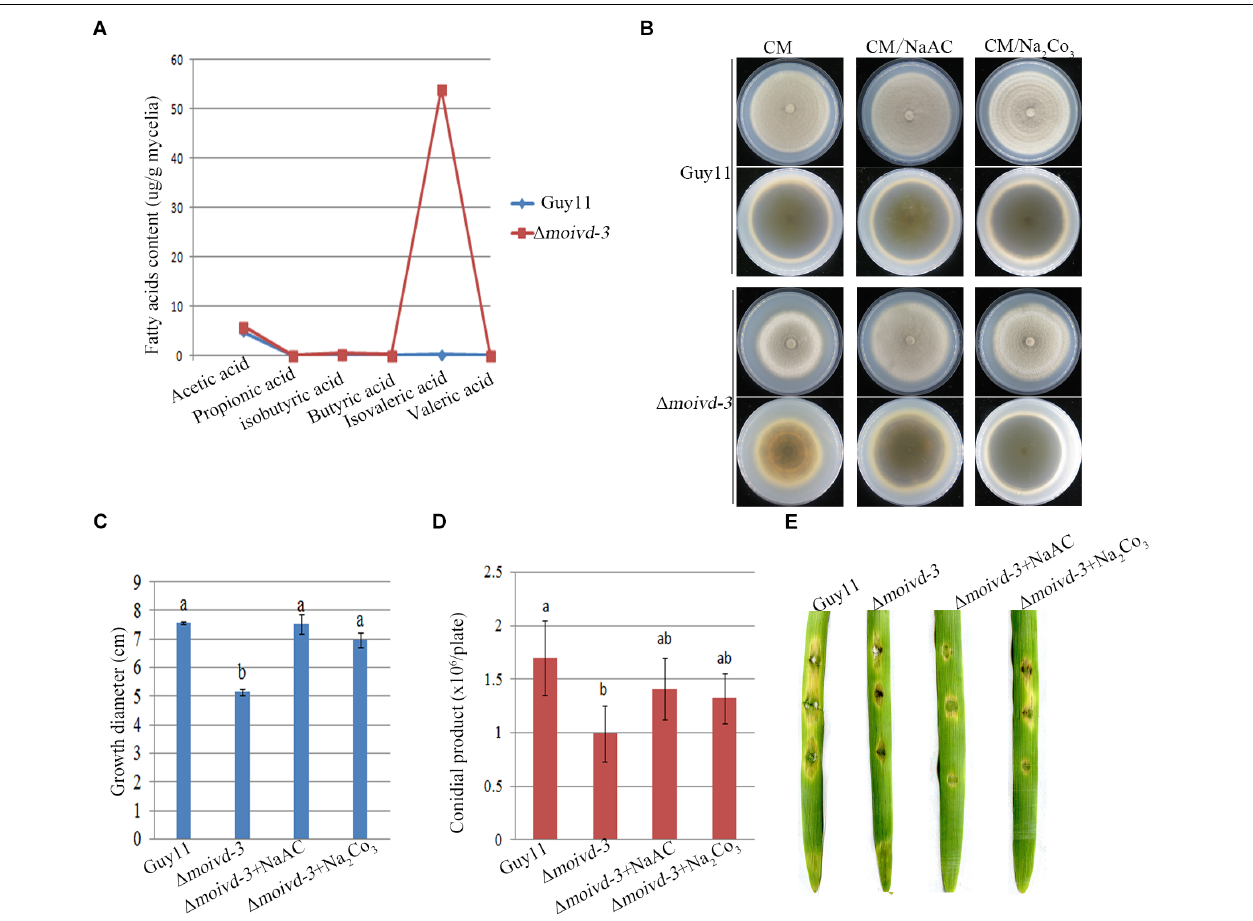
FIGURE 6 | Isovaleric acid accumulation in (cid:49) moivd-3 and the effect of exogenous NaAc and Na 2 Co 3 to mutant phenotype. (A) Line chart showing 6 short chain fatty acid content tested by GCMS. (B) The growth phenotype of (cid:49) moivd-3 growing on NaAc and Na 2 Co 3 treated CM medium. (C) Bar chart showing the growth size of (cid:49) moivd-3 growing on NaAc and Na 2 Co 3 treated CM medium. (D) Bar chart showing the conidial product of (cid:49) moivd-3 growing on NaAc and Na 2 Co 3 treated CM medium. (E) No effect of NaAc or Na 2 Co 3 on the virulence of (cid:49) moivd-3 on excised barley leaves. All the data were calculated from three independent replicates. The same lowercases ‘a’ or ‘b’ on the sample bar indicate no significant differences between samples. The different lowercases indicate significant differences ( P < 0.05; t